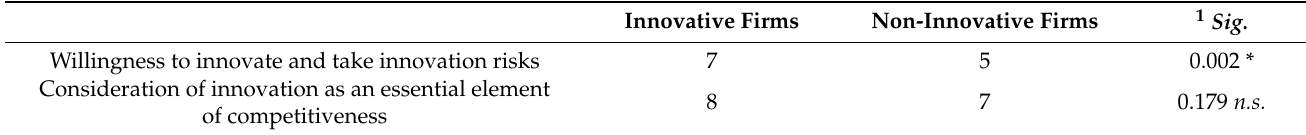
Table 3. Mann–Whitney test: willingness to innovate and competitiveness.